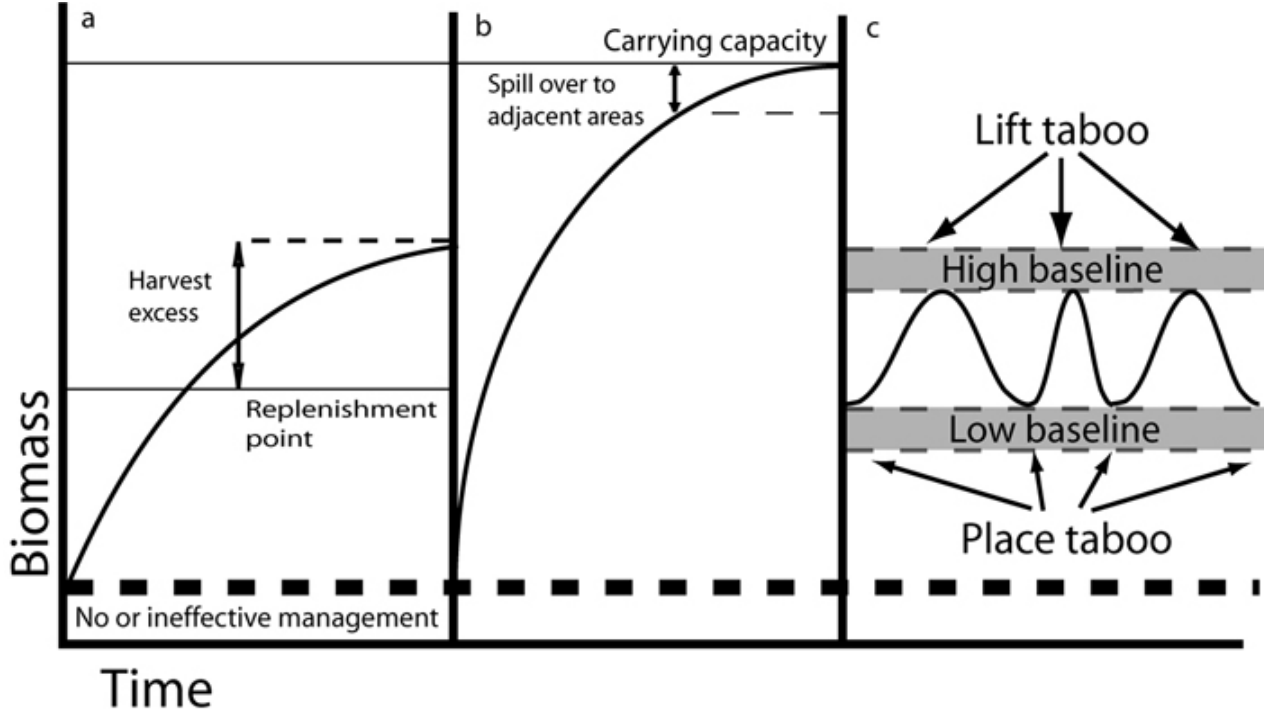
Fig. 4 . Comparison of models (a) sustainable fisheries management, (b) closed areas, and (c) adaptive management using periodic